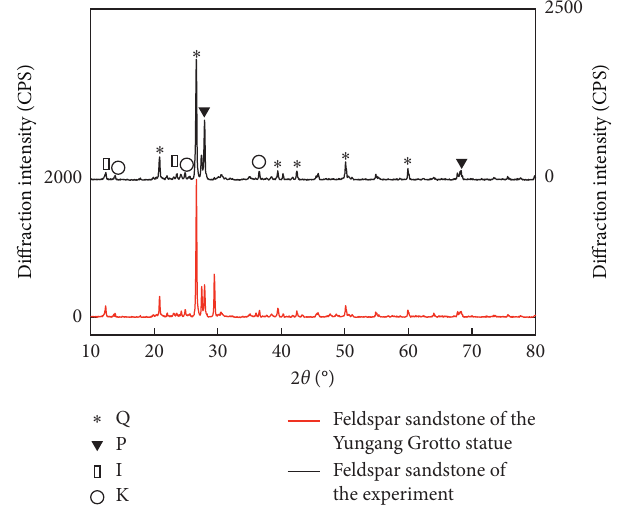
Figure 1: X-ray diffraction